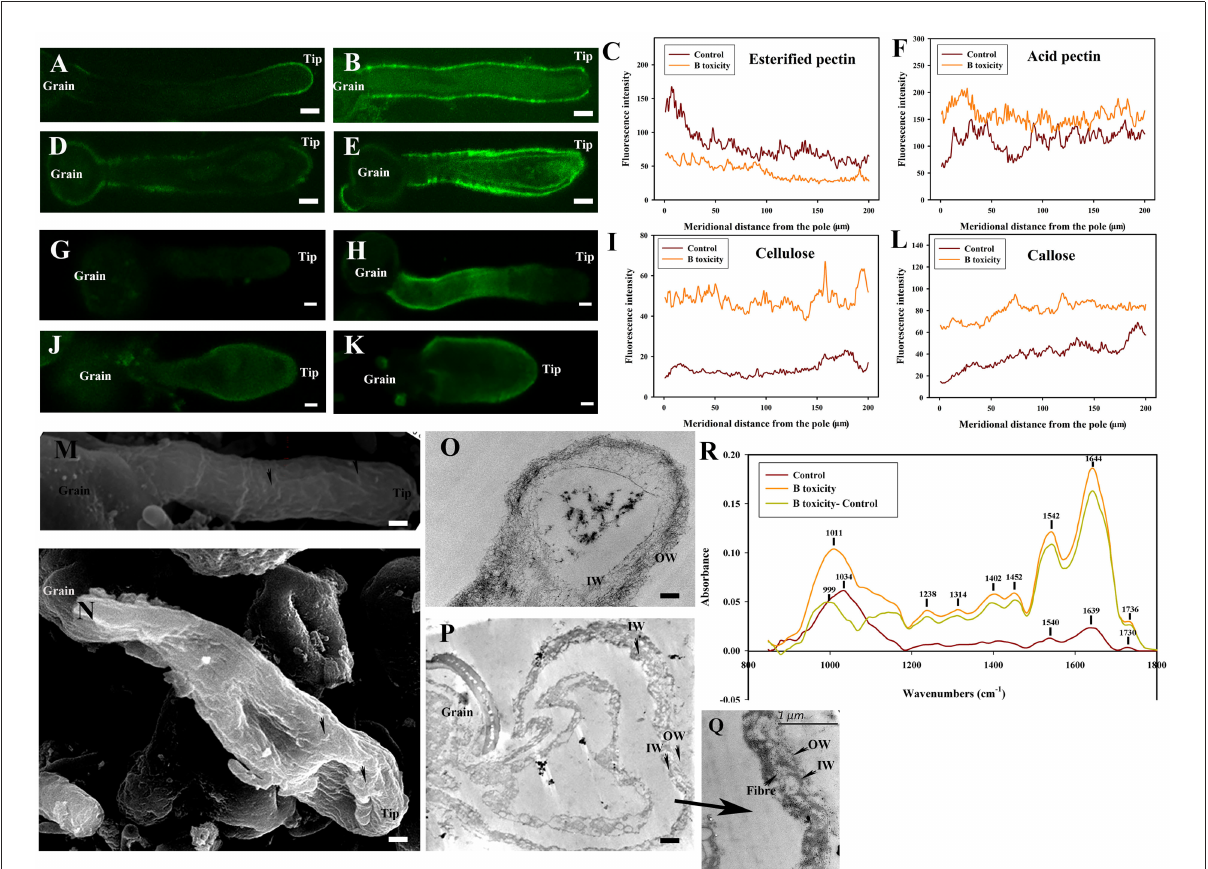
FIGURE6 Effects of B toxicity on cell wall architecture with cellulase treatment. (A) Esterified pectins labeled with JIM7 in control pollen tube treated with cellulase. (B) Esterified pectins in B toxicity-treated pollen tube treated with cellulase. (C) Quantitative analysis of the fluorescent intensity of esterified pectins in the wall of control (Control) and B toxicity treated pollen tubes which were digested with cellulase. (D) Acid pectins indicated by JIM 5 labeling in control pollen tube treated with cellulase. (E) Acid pectins in B toxicity-treated pollen tube treated with cellulase. (F) Quantitative analysis of acid pectins fluorescent intensity in the wall of control pollen tubes (Control) and B toxicity-treated pollen tubes which were digested with cellulase. (G) Cellulose in control pollen tube digested with cellulase indicated by CBM3a labeling. (H) Cellulose in B toxicity-treated pollen tube and then digested with cellulase. (I) Quantitative analysis of the fluorescent intensity of cellulose in the wall of control (Control) and B toxicity-treated pollen tubes that were digested with cellulase. (J) Callose in control pollen tube indicated by monoclonal antibody to (1 → 3)- β -glucan labeling digested with cellulase. (K) Callose in B toxicity-treated pollen tube digested with cellulase. (L) Quantitative analysis of callose fluorescent intensity in the wall of control (Control) and B toxicity-treated pollen tubes that were digested with cellulase. (M) SEM of control pollen tube digested with cellulase. (N) SEM of B toxicity-treated pollen tube digested with cellulase. (O) TEM transverse section of control pollen tube digested with cellulase. The fibrous pectic layer in OW became loosened. (P,Q) TEM transverse section of B toxicity-treated pollen tube digested with cellulase. A small number of fibers were present in OW, but much more fibers were crosslinked with the callose layer. (R) FTIR spectra from the tip regions of C . mollissima pollen tubes digested with cellulase (control pollen tube: Control), B toxicity-treated pollen tubes digested with cellulase and the FTIR differential spectrum (B toxicity – control) generated by digital subtraction of the control spectra from B toxicity-treated spectra digested with cellulase (B toxicity). Bar = 10 µ m in (A,B,D,E,G,H,J,K) . Bar = 3 µ m in M and N; Bar = 2 µ m in (O,P) . OW, Outer wall; IW, inner wall. The arrows showed the wave morphology (M) and wave protuberances (N)